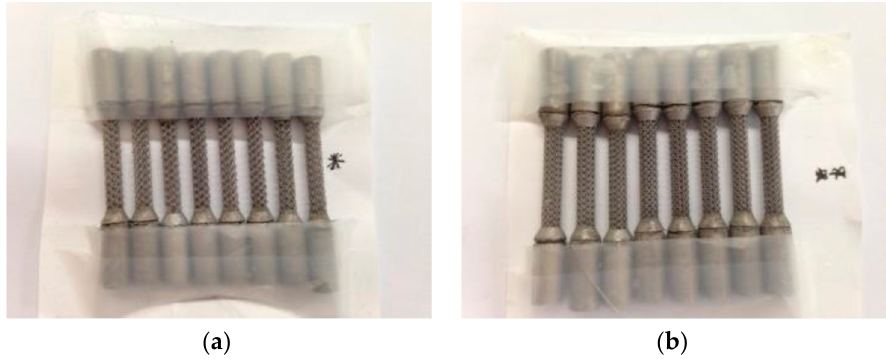
Figure 1. Alloy scaffolds’ structures samples: cylinders ( a ) 1000 μ m and ( b ) 750 μ m received from KUL Leuven, Belgium.